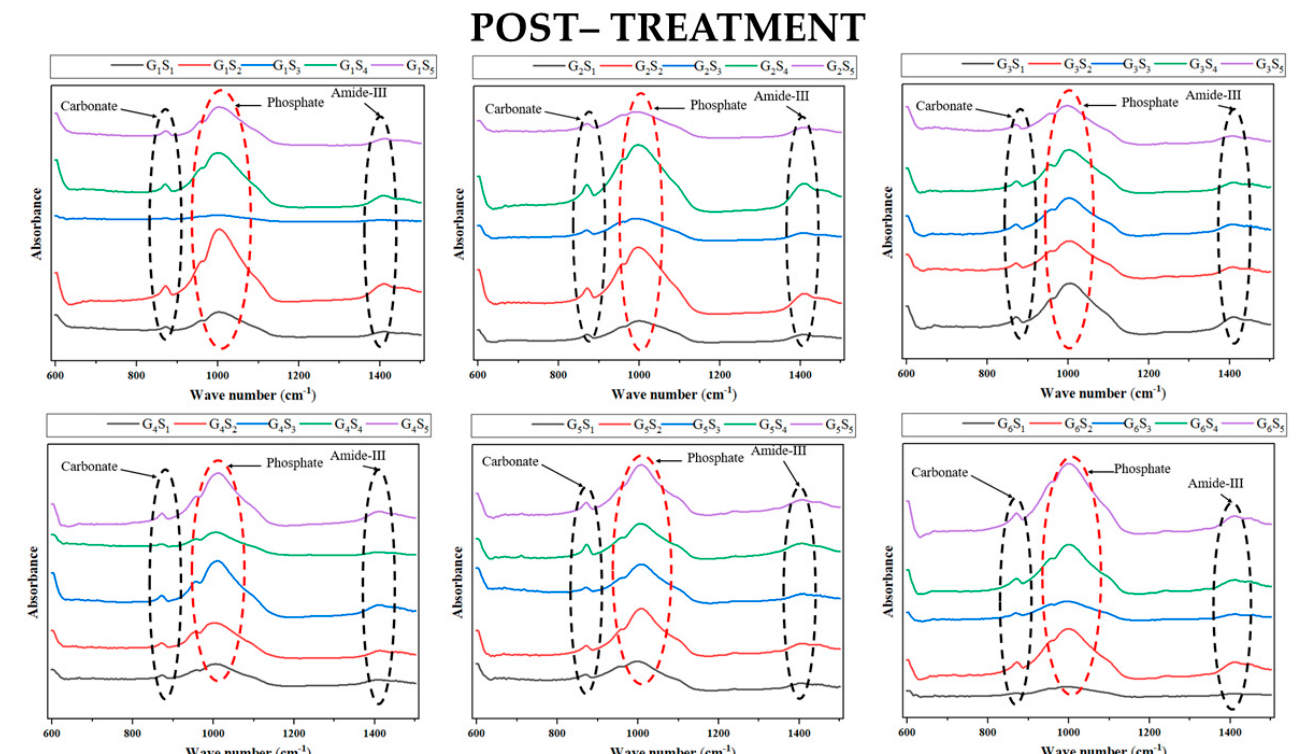
Figure 1. Raw data; FTIR spectra of all the samples (5 samples per group/irrigant: S 1 to S 5 ) after 30 min of exposure to test and control irrigants. G 1 = 2.5% NaOCl, G 2 = 5.25% NaOCl, G 3 = 9% Dual Rinse HEDP in 2.5% NaOCl, G 4 = 9% Dual Rinse HEDP in 5.25% NaOCl, G 5 = 9% Dual Rinse HEDP in physiological saline solution, G 6 = physiological saline solution (control). Note the more homogeneous appearance of the phosphate peaks in the groups irrigated with HEDP (G 3–5 ).